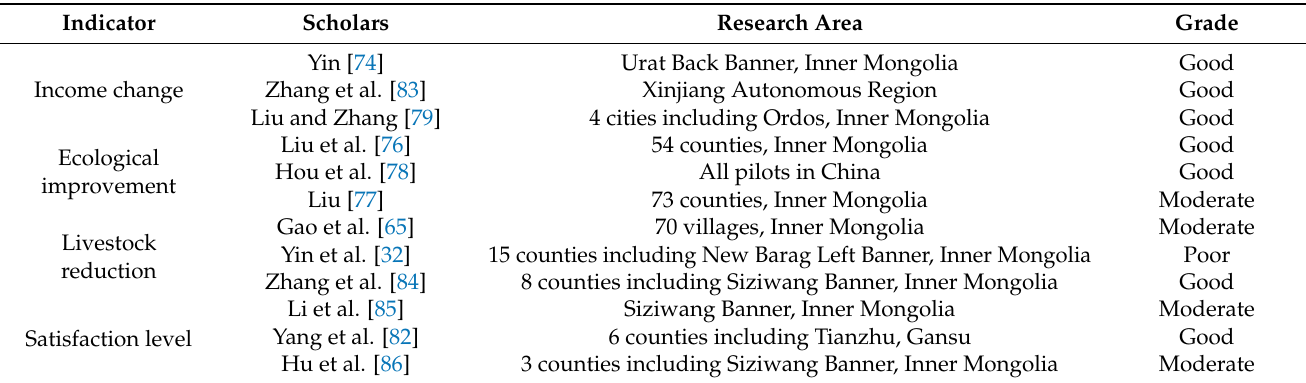
Table 3. Results of PSRGEP effect